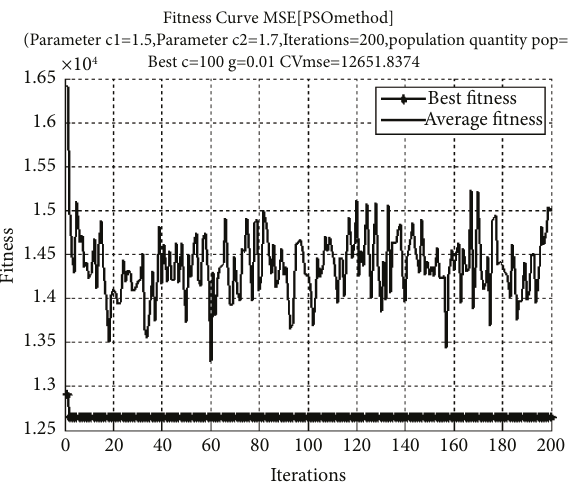
Figure 9: PSO-SVM optimization process of CO